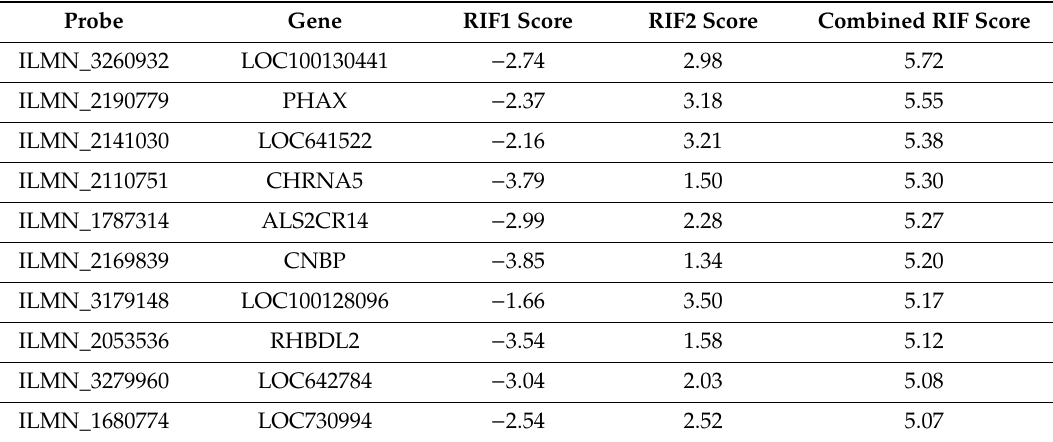
Table 1. The top 10 most di ff erentially connected probes in sunitinib treated versus control kidney cancer cells. Ranking was performed on the absolute average of RIF1 and RIF2 scores. PHAX was awarded the highest combined RIF scores of the annotated